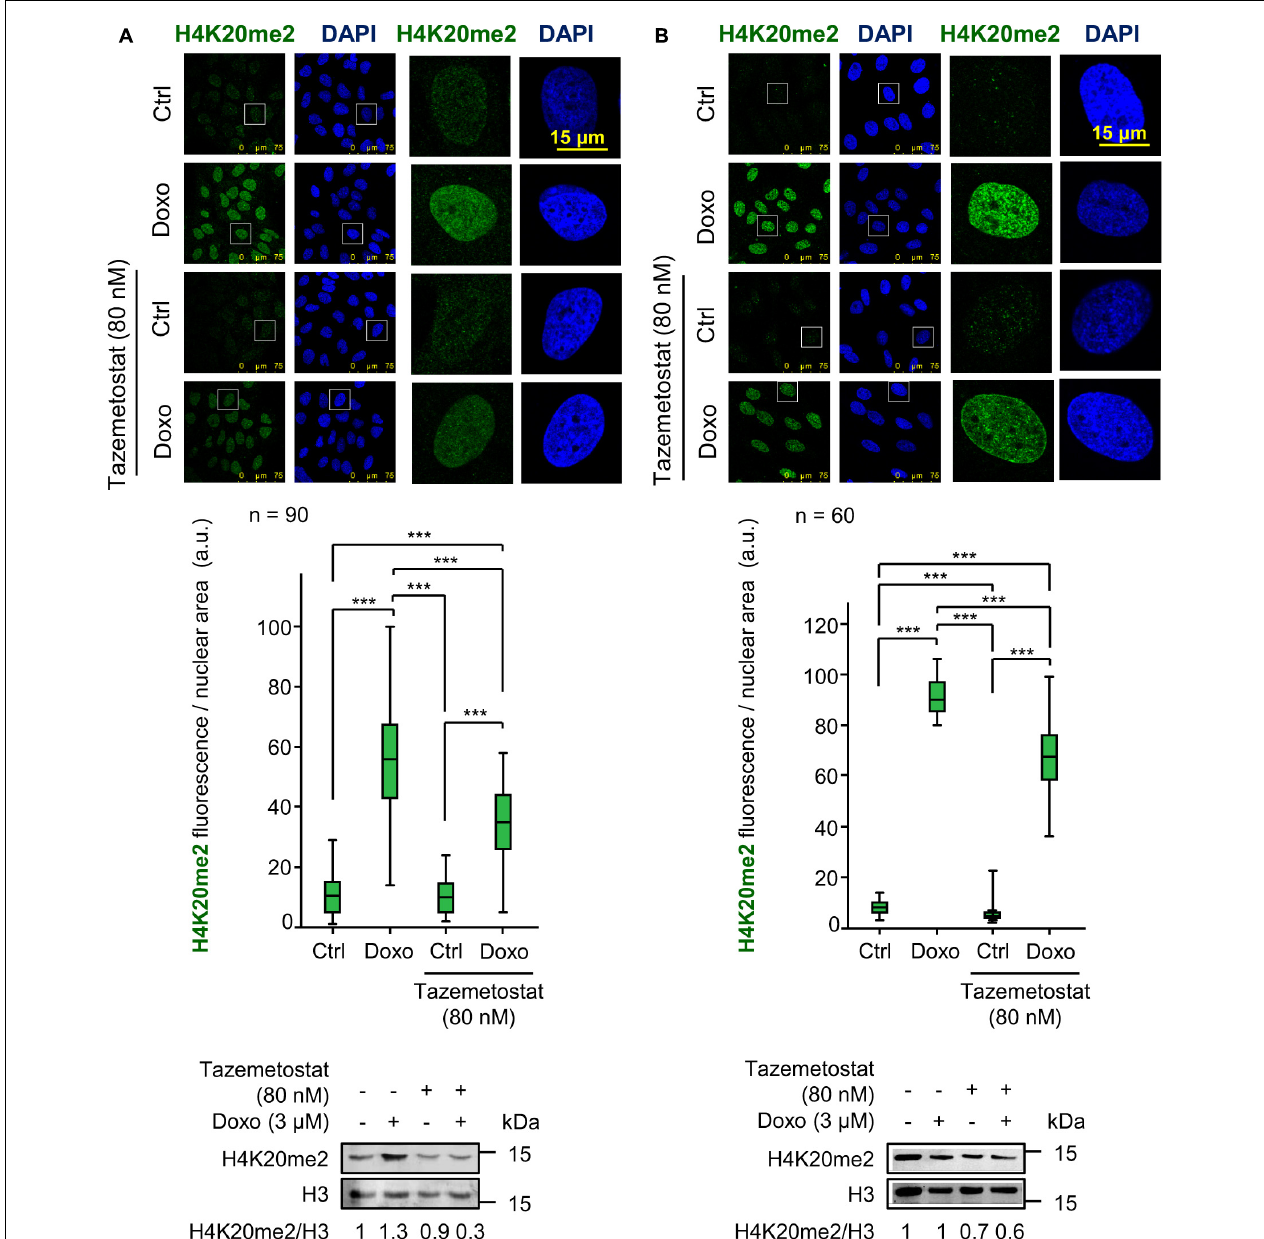
FIGURE 6 | Effect of tazemetostat (TZM) on H4K20me2 levels in response to DNA damage induced by doxorubicin. (A) Effect of tazemetostat on the levels of H4K20me2 in U2OS cells deprived of serum. The tazemetostat effect on γ H2AX and 53BP1 is shown in Figure 7 . (B) Effect of tazemetostat on the levels of H4K20me2 in SK-LMS-1 cells. The tazemetostat effect on γ H2AX and 53BP1 is shown in Supplementary Figure 9 . *** p < 0.001. Ctrl, control without